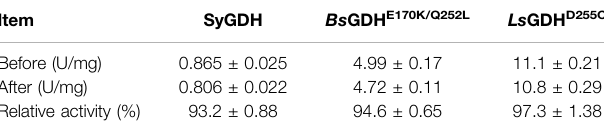
TABLE 3 | Analysis of the activities of the three glucose dehydrogenases before and after heat treatment.